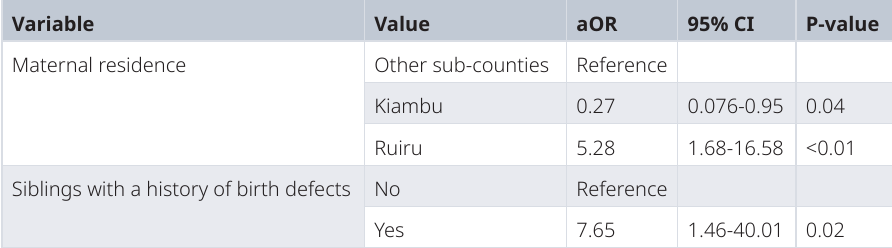
Table 5. Multivariable analysis of factors associated with MESBDs among children in Kiambu County,